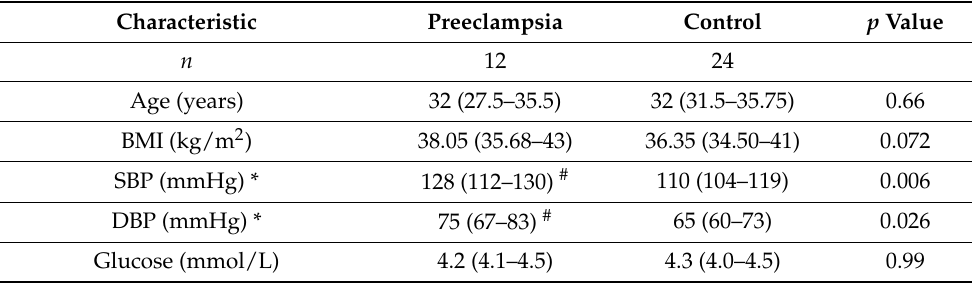
Table 1. Clinical characteristics of participants at 28 weeks